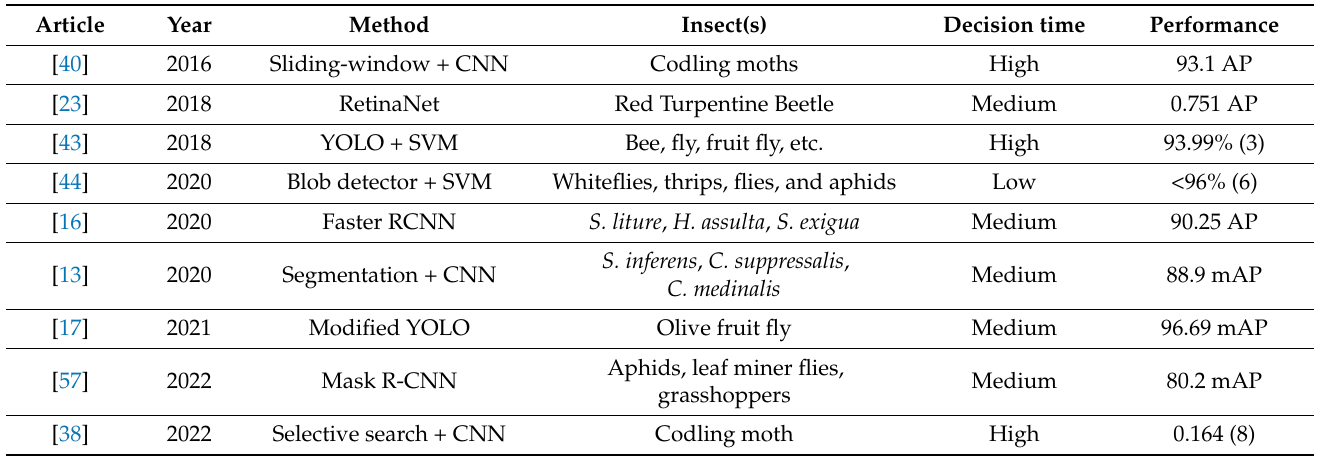
Table 4. Main characteristics of insect counting